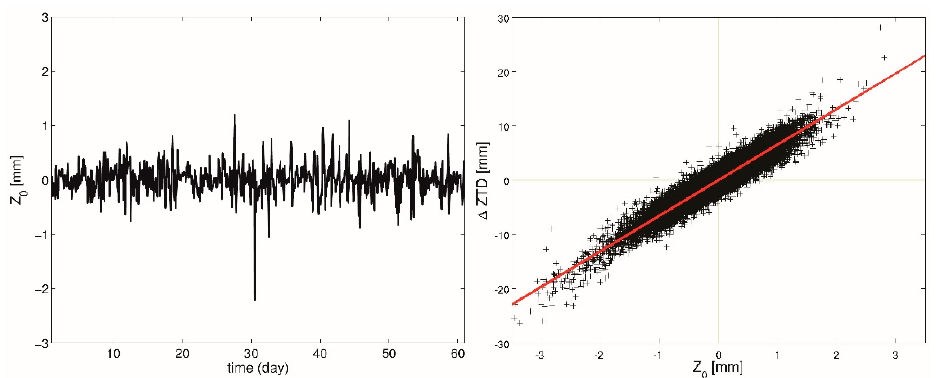
Figure 7. Left panel: the tropospheric parameter Z 0 for the POTS station as a function of time. Right panel: the error in the ZTD as obtained from the fourth simulation experiment versus the tropospheric parameter Z 0 for all stations and epochs analyzed. The red line indicates the linear fit.